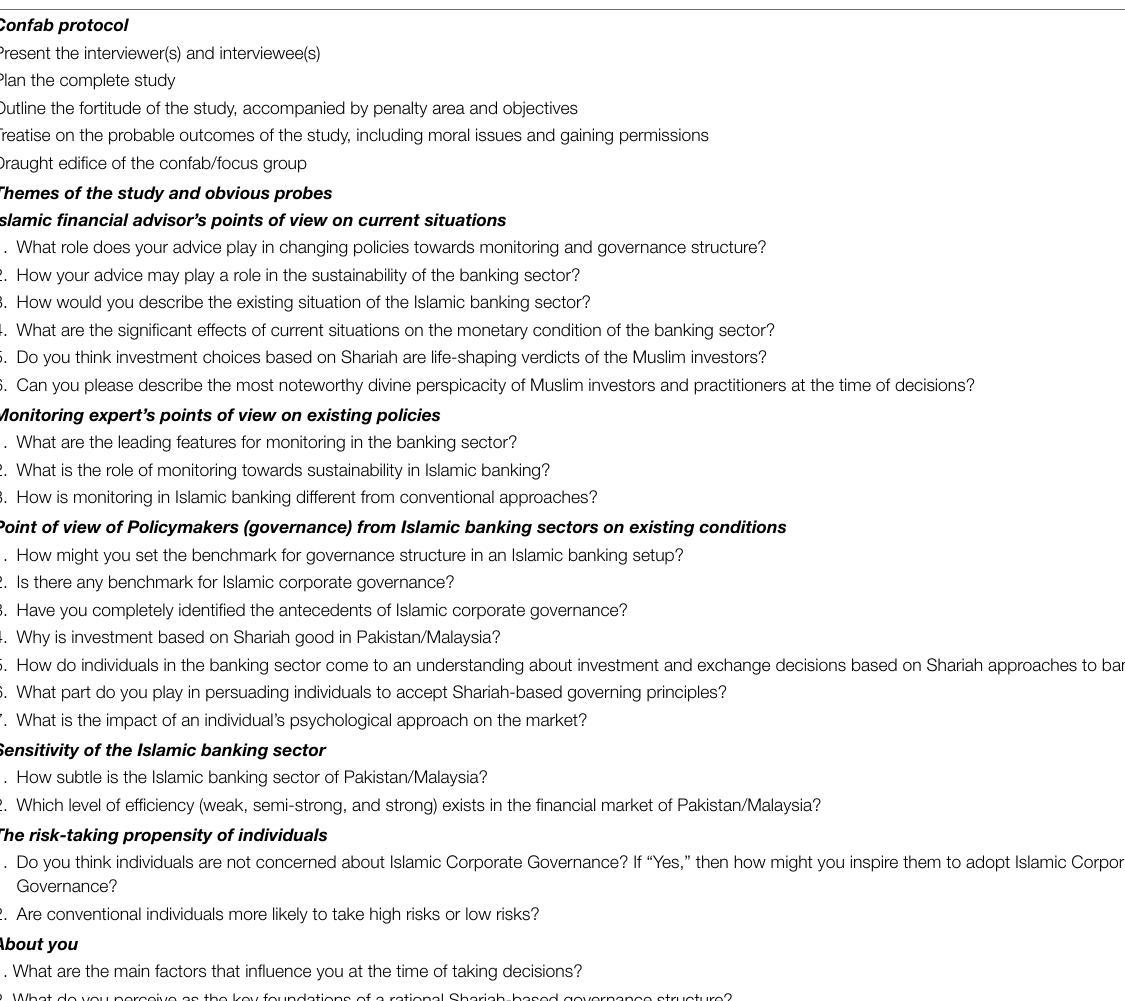
TABLE 3 | Confab protocol and